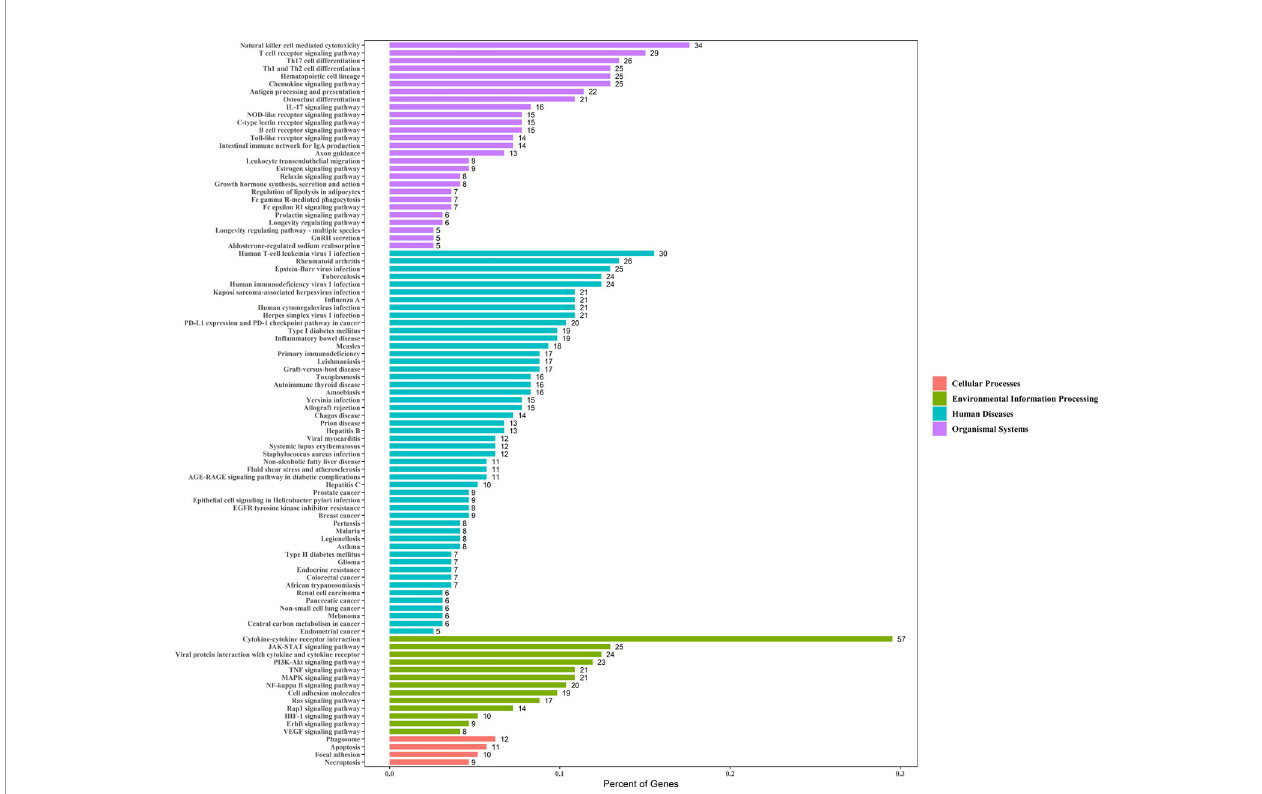
FIGURE 4 | The X-axis represents the Percent of Genes. The Y-axis represents the KEGG pathway terms and the KEGG pathway terms were assigned to four KEGG